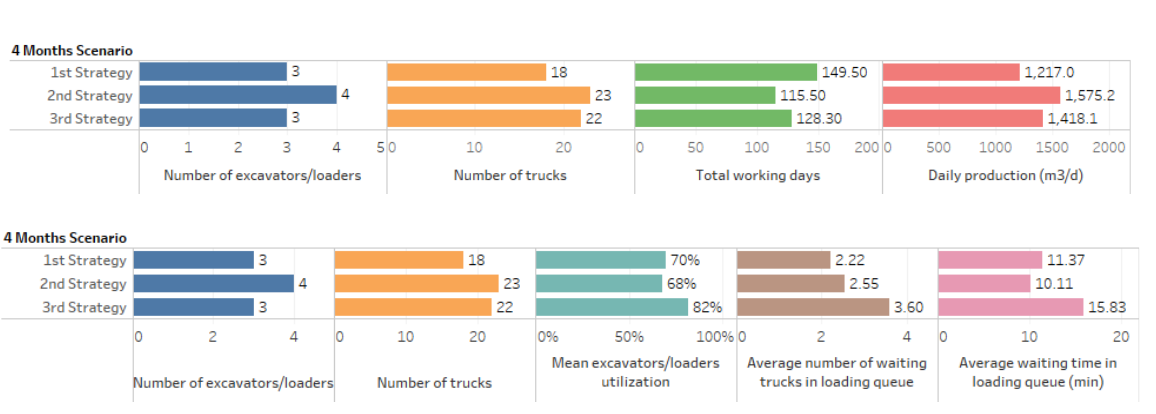
Figure 10. Simulation results of the various strategies for scenario #3.